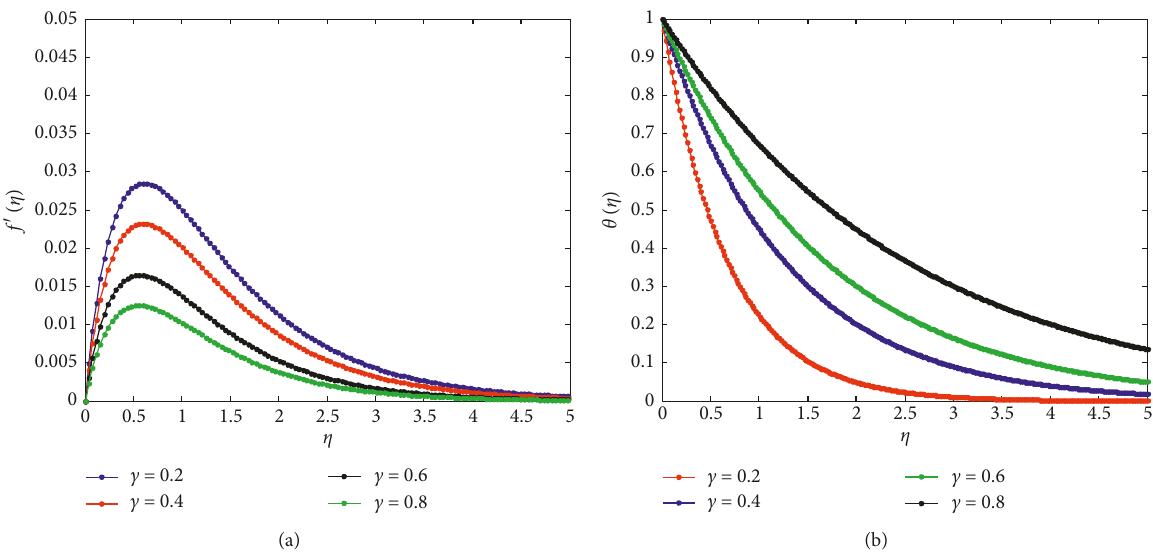
Figure 4: (a) Effects of Casson parameter on the velocity profile of the Casson nanofluid. (b) Effects of Casson parameter on the temperature profile of the Casson